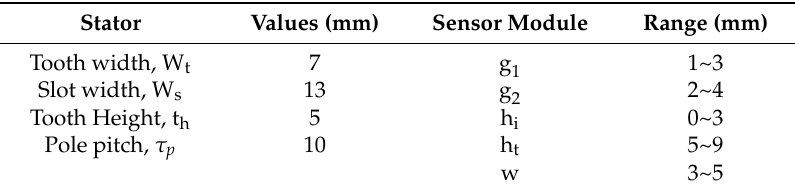
Table 1. Specification for the Stator and Sensor